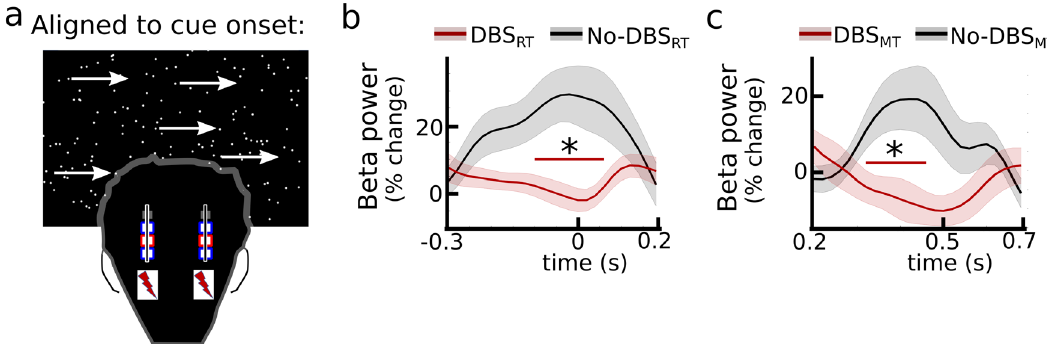
Fig. 5 | Local fi eld potential recordings during stimulation. a Beta power is aligned to cue onset. B Cue-aligned beta power for trials where stimulation was appliedduringDBS RT (red)comparedtotrialswherestimulationwasnotappliedin DBS RT (termed No-DBS RT , black) averaged across participants ( n =10). Signi fi cant differences according to cluster-based permutation tests are marked by red bars